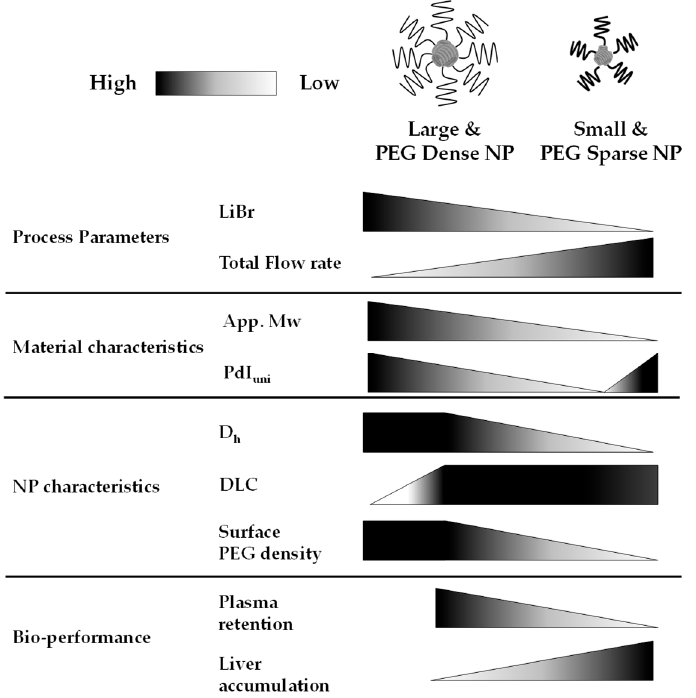
Figure 8. Schematic summary of the relationship between process parameters in the preparation of NPs.